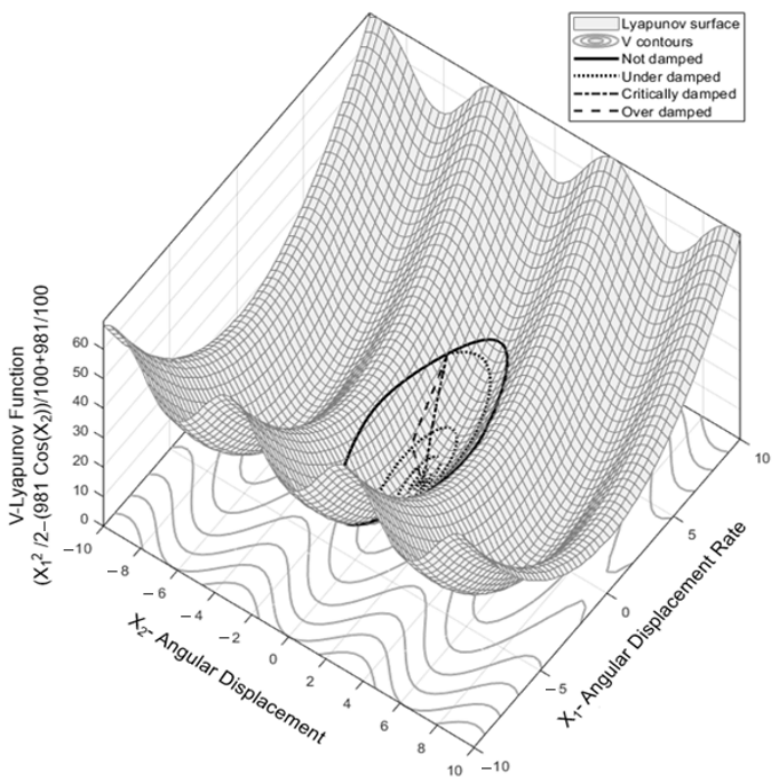
Figure 8. Lyapunov function (V), indicative of global asymptotic stability for the lumped mass dy ‐ namic system (Case example 1) along with the system phase portraits under [2, 1.5] state initial value.